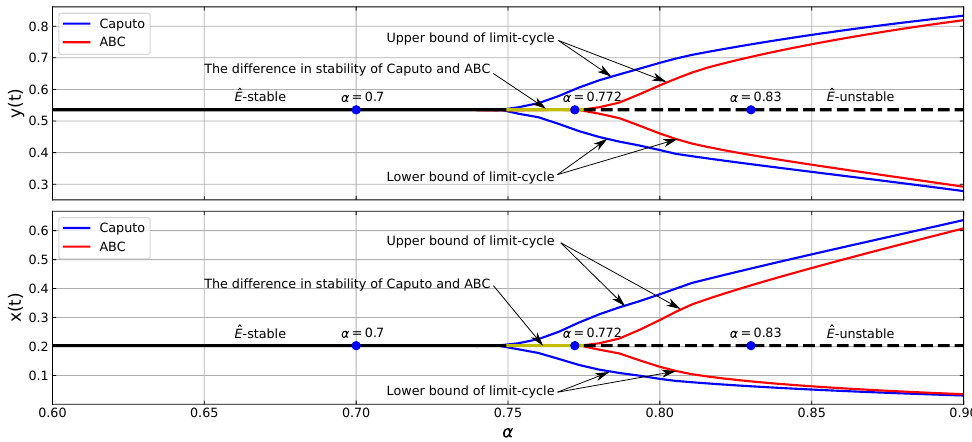
Figure 6. Bifurcation diagram of Caputo model (6) and ABC model (16) driven by the order of the fractional-derivative ( α ) with constant parameter values (29) and n = 0.2. There exists a Hopf bifurcation where the bifurcation points of the Caputo model and ABC model are different.